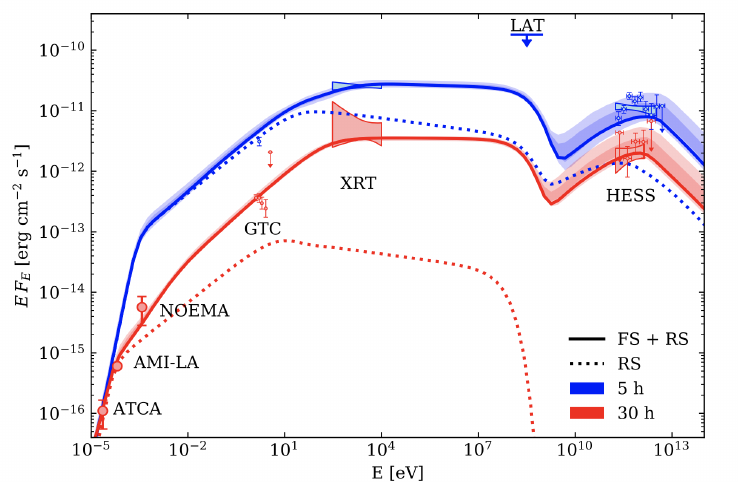
Figure 10. SEDs and MWL modelling of GRB190829A at two different epochs (first and second night of H.E.S.S. observations). Top : XRT (black regions), LAT (green arrow, available only for the first night), and H.E.S.S. intrinsic spectrum with its uncertainty (statistical only, red regions). The shaded areas represent the 68% confidence intervals for the SSC model (light blue) and for the synchrotron model (orange). Dashed lines indicate the synchrotron component, while the dash-dotted lines show the inverse Compton components, neglecting internal γ - γ absorption. Bottom : modelling from radio to TeV proposed by [75]. The predicted SEDs at the times of the H.E.S.S. detections are shown with blue and red solid lines at 5 and 30 h, respectively, and are based on a synchrotron and SSC interpretation. A reverse shock component (dotted curve) dominates the radio observations. Confidence bands with 90% and 50% confidence levels are marked in lighter